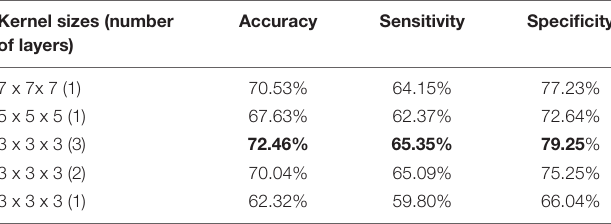
TABLE 3 | Classification performance of different convolutional kernel sizes. Kernel sizes (number of layers)